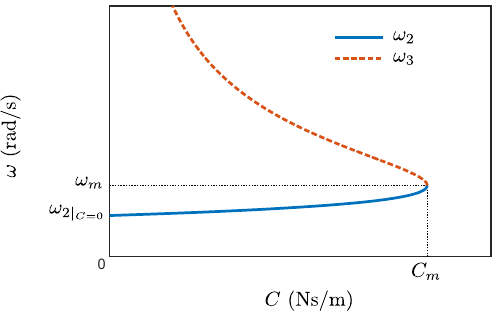
Figure 5. Evolution of the speeds ω 2 and ω 3 with the external damping C